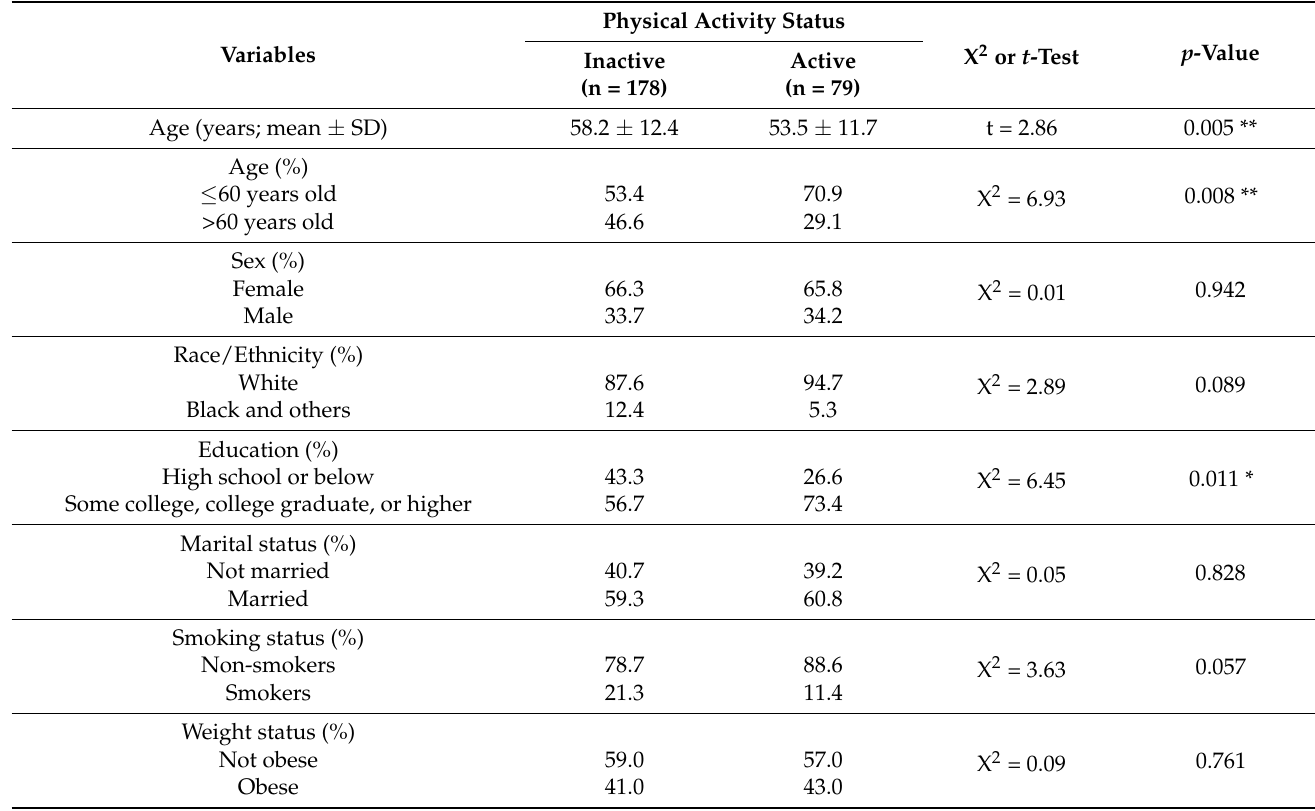
Table 1. Sample characteristics and comparison of physical activity status on all study variables in COPD